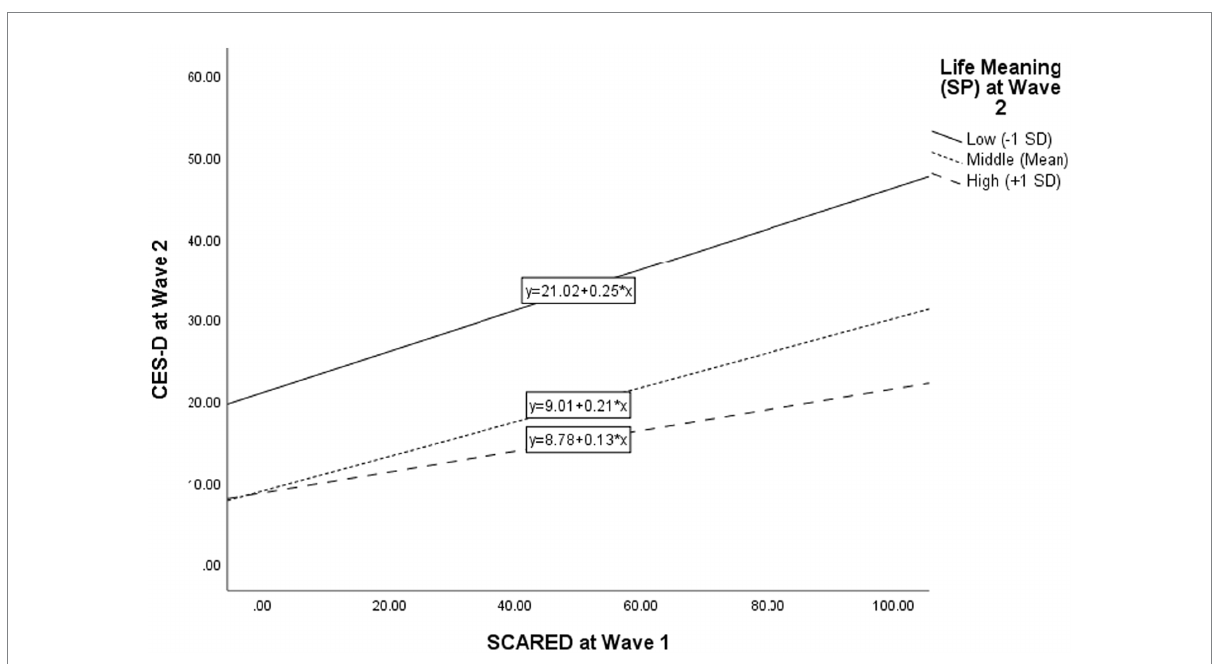
FIGURE 1 Moderating effect of SP at Wave 2 on the relationship between SCARED at Wave 1 and CES-D at Wave